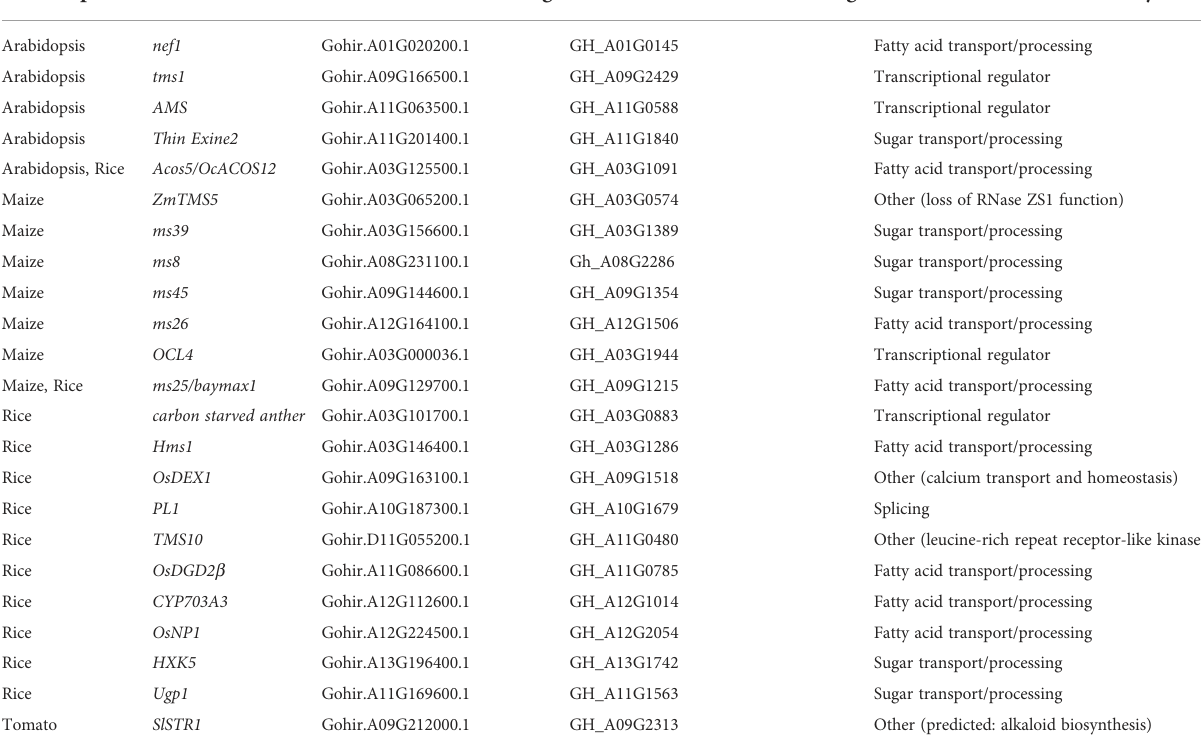
TABLE 2 Twenty-three candidate genes identi fi ed for male sterility in upland cotton through homology-based analysis. Source species